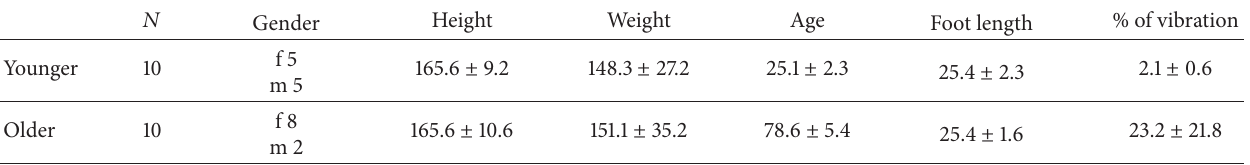
Table 1: Anthropometric characteristics of younger and older participants and sensory threshold expressed as fraction of potential maximum amplitude output of the vibrotactile